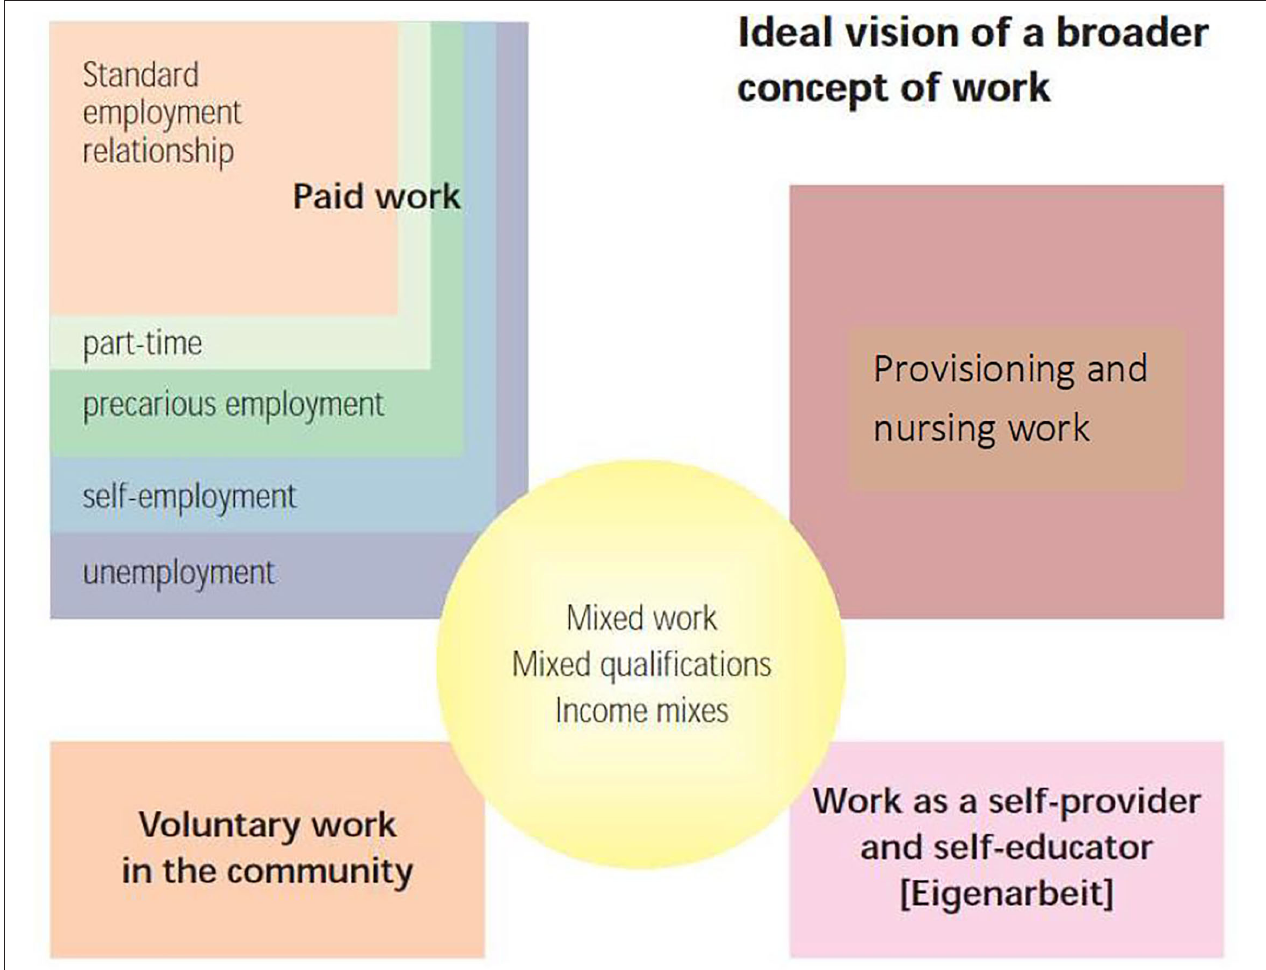
FIGURE 1 | A broader concept of work. Source: Hans-Böckler-Stiftung (2000). Pathways to a sustainable future. Results from the work and environment interdisciplinary project. HBS, Düsseldorf;